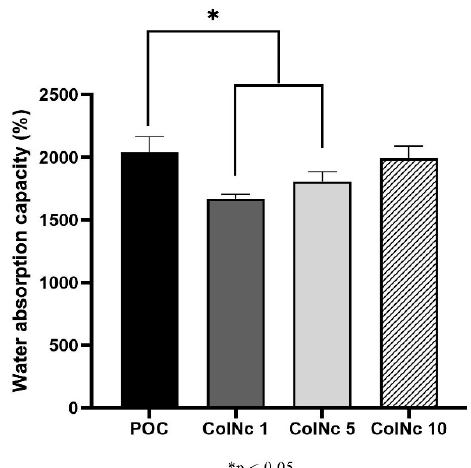
Figure 1. The water absorption capacity (%) of bilayer hybrid scaffold fabricated by different concentration of nanocellulose. The water absorption capacity increased with increasing concentration of nanocellulose in the treated group while POC remained as the highest among all of the samples. (*) represents a significant difference ( p < 0.05; n = 3) between control group, POC.